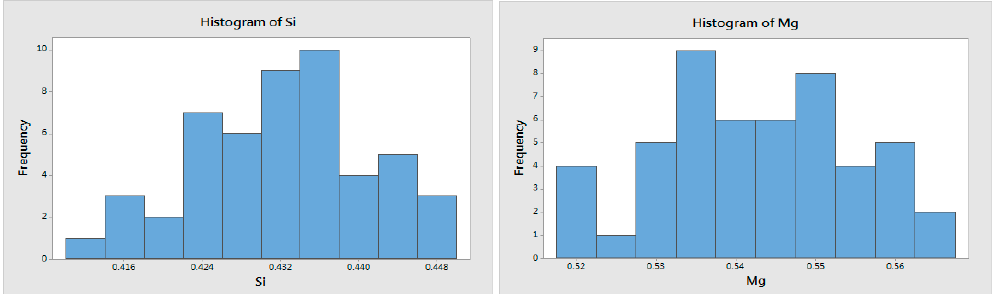
Table 4. Adjusted 6063 aluminum alloy rods’ composition used by Company